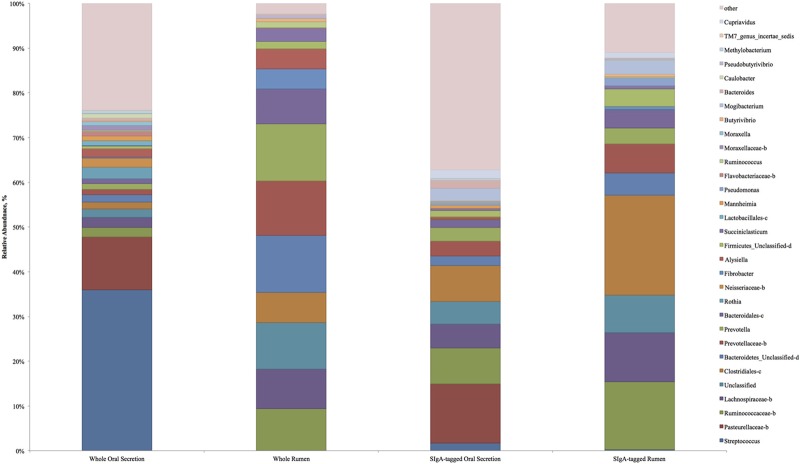
Relative abundance of predominant microbial taxa in whole and SIgA-tagged oral secretion and rumen samples. Letter behind taxonomy indicates unclassified: b – genus, c – family and genus, d – order, family and genus.